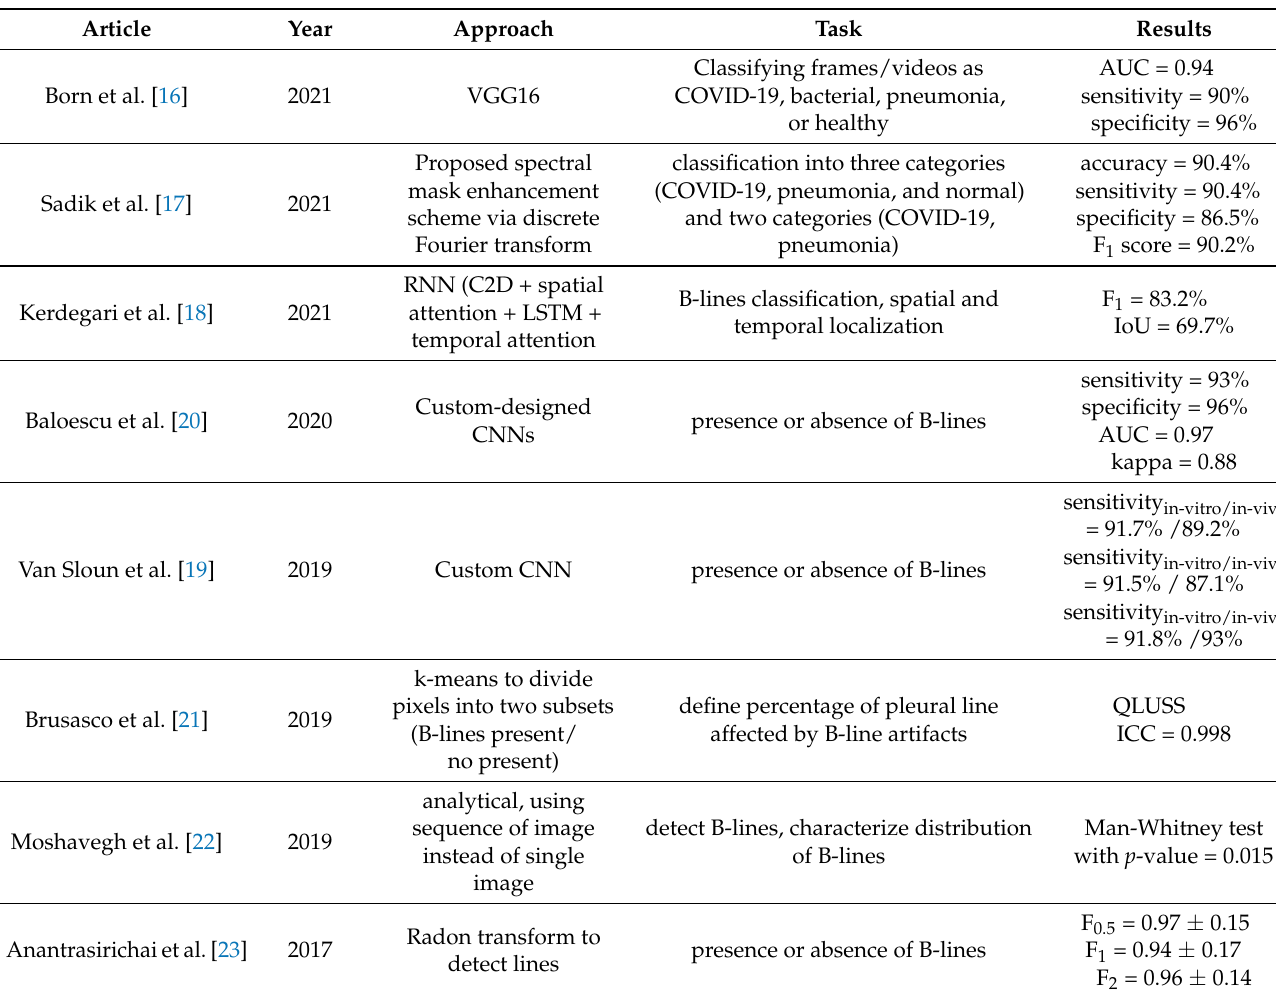
Table 1. Related work in LUS image